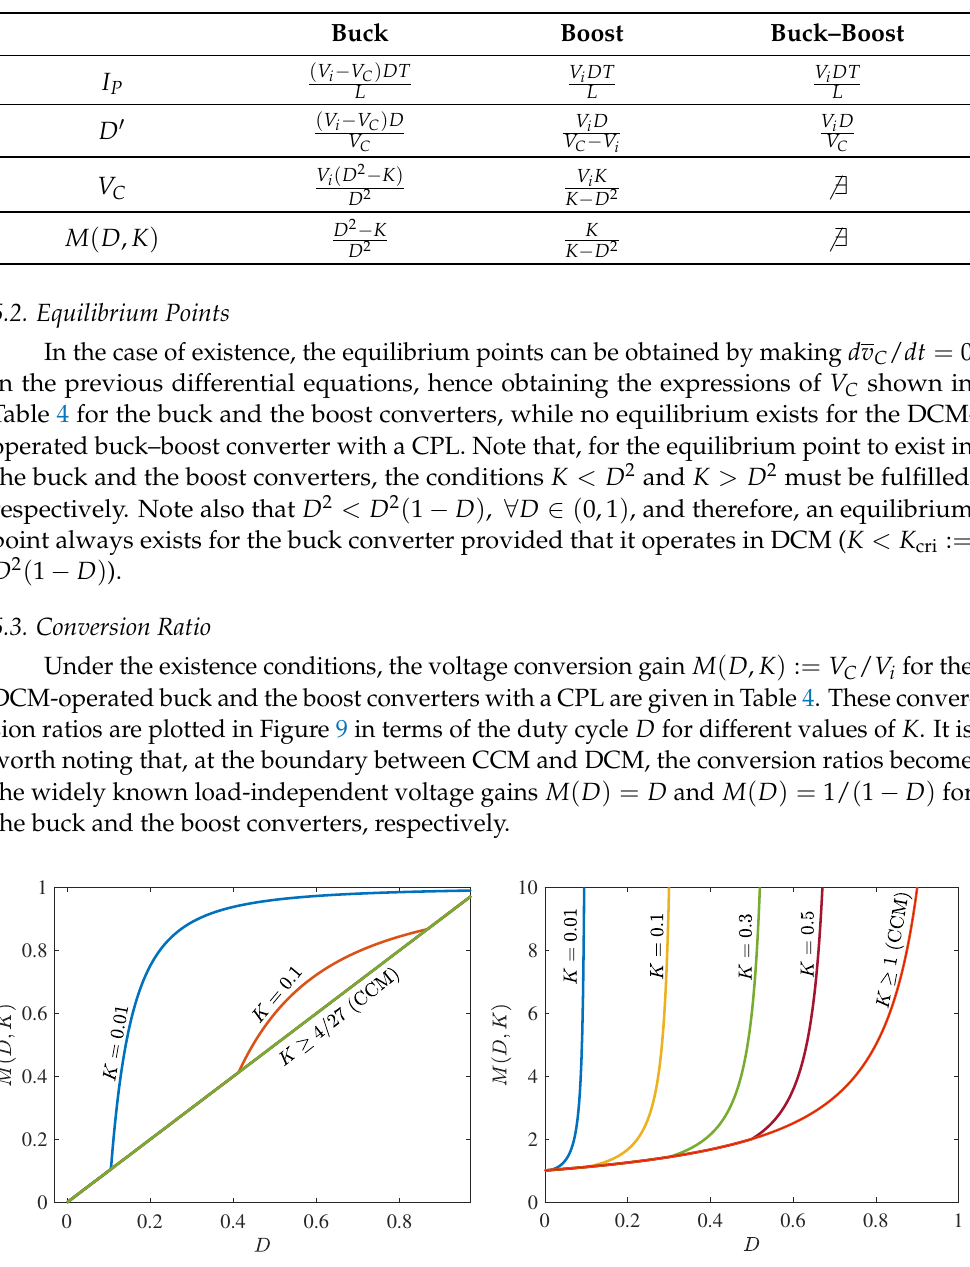
Table 4. Peak current I P , ratio D (cid:48) , averaged voltage V C , and conversion ratio M ( D , K ) for the three converters with a CPL under DCM operation.